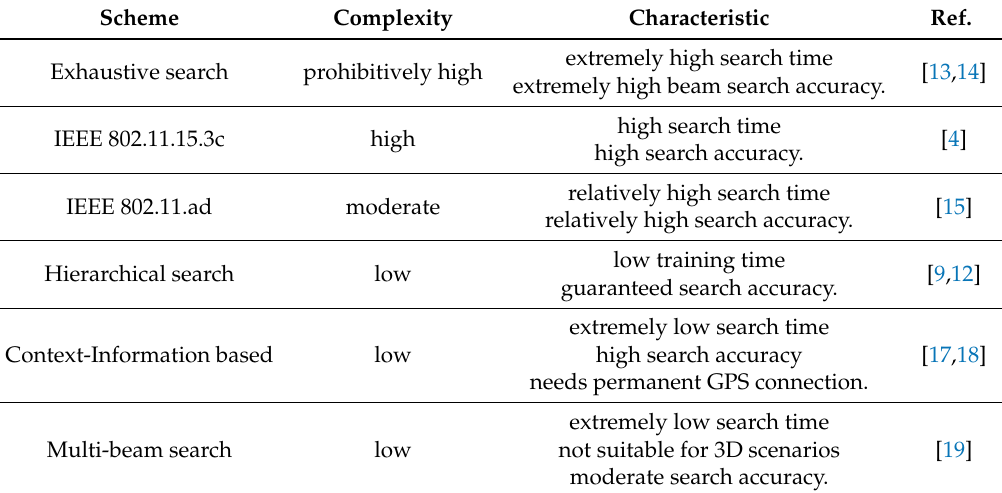
Table 1. Comparison of mmWave beam training